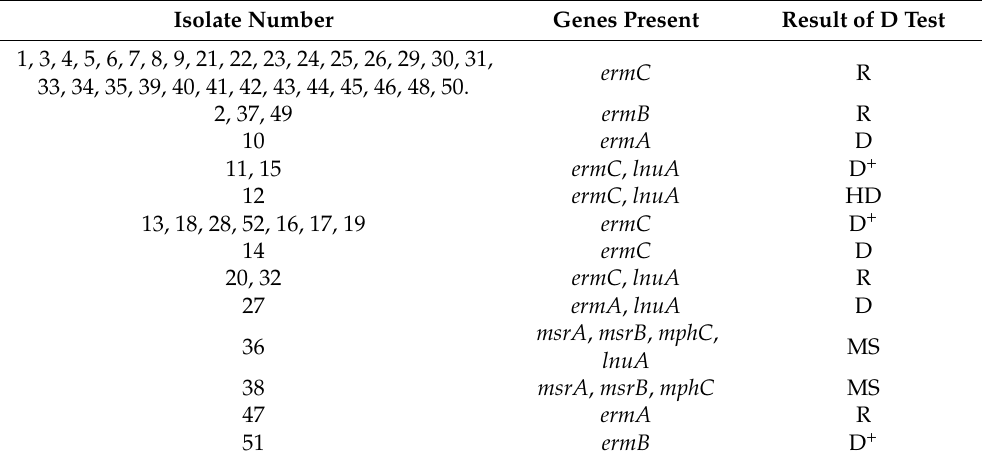
Table 1. Genotypes of macrolide-lincosamide-streptogramin B (MLS B )-resistant S. aureus clinical isolates. Isolate Number Genes Present Result of D